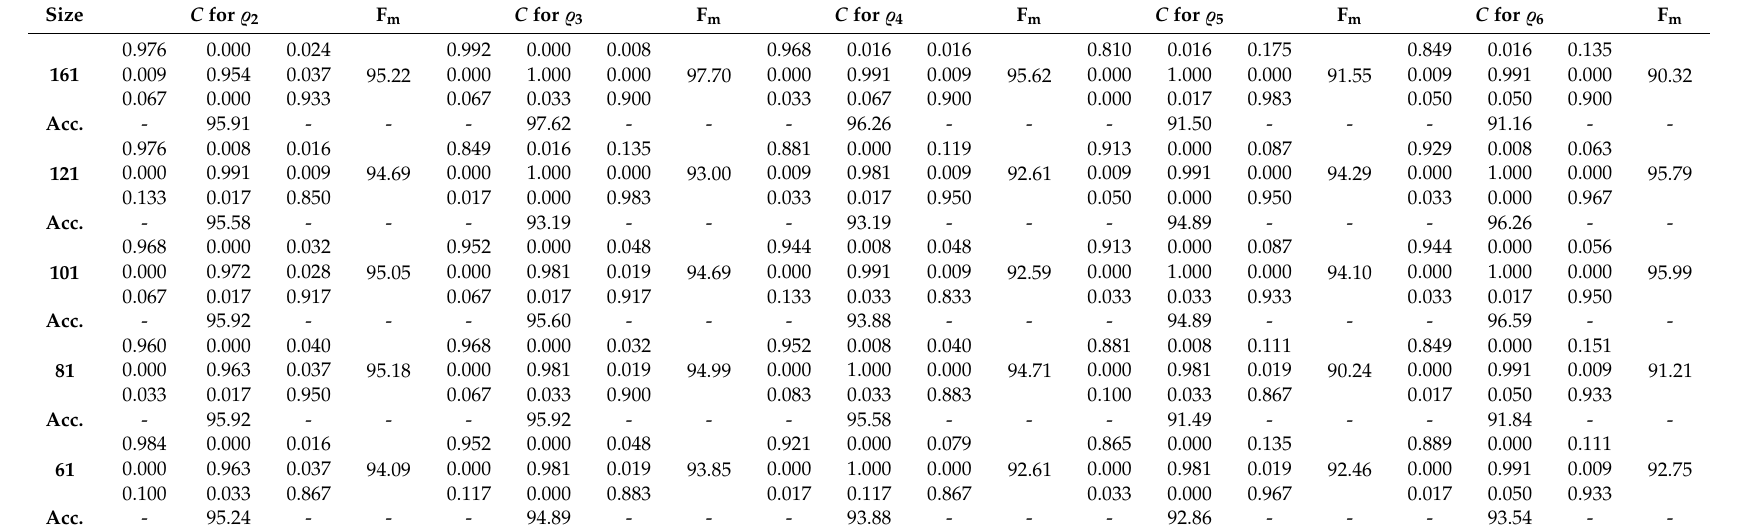
Table 5. Performance of the naïve Bayes classifier for di ff erent combinations of textural